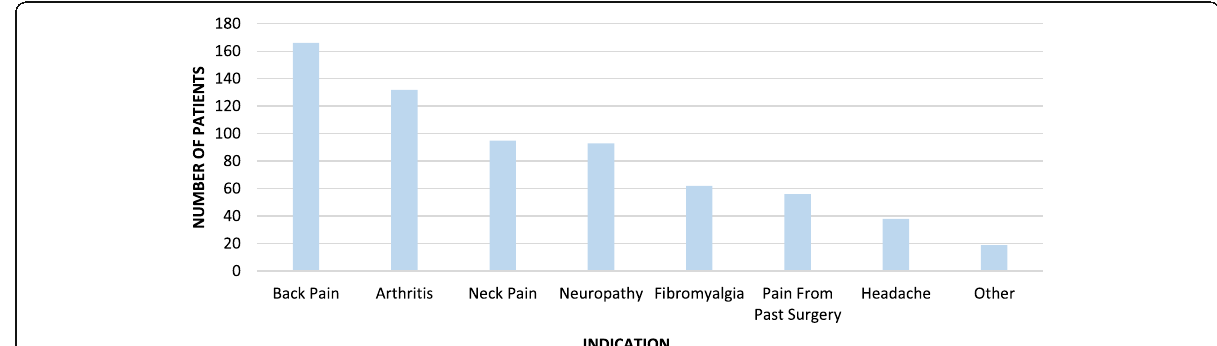
Fig. 1 Responses to question 7: Primary complaints/indications for medical marijuana among those willing to consider it ( n = 204). Respondents were allowed multiple